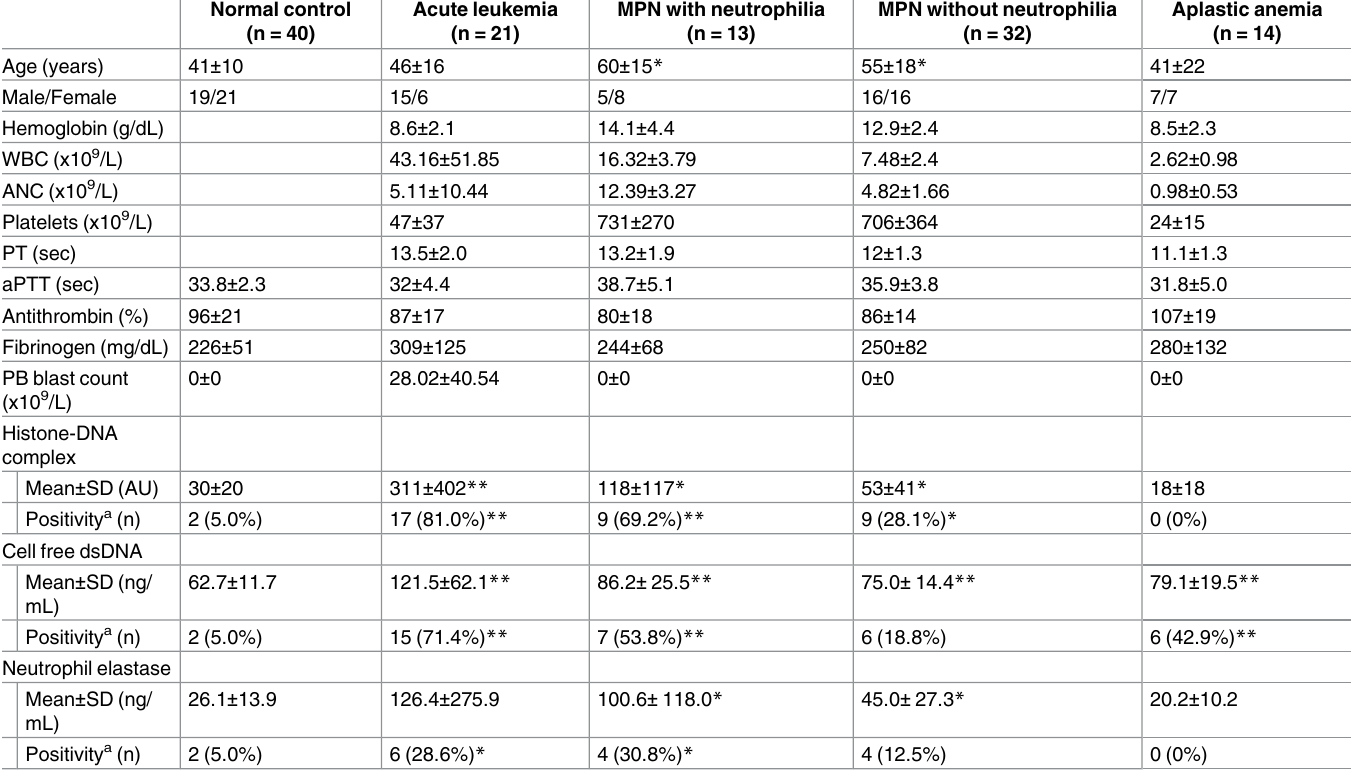
Table 1. The baseline characteristics and laboratory results of the study populations.